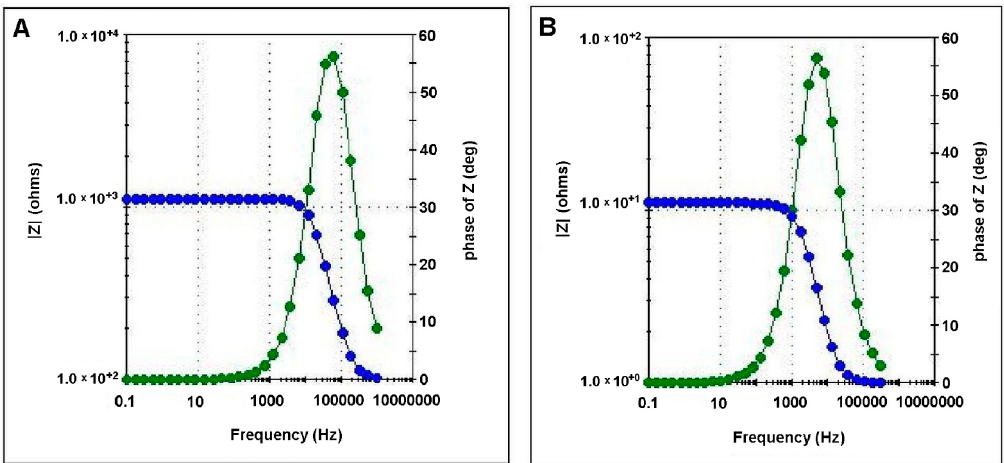
Figure 8. Bode diagrams for CA / PEG membrane ( A ) and CA / PEG / CHI-Ag membrane ( B ). The displacement of the semicircle on the diagram towards origin with the simultaneously decreasing in the semicircle size upon adding CHI-Ag in the membrane composition signifies that the membrane conductivity is not electronic, but ionic.